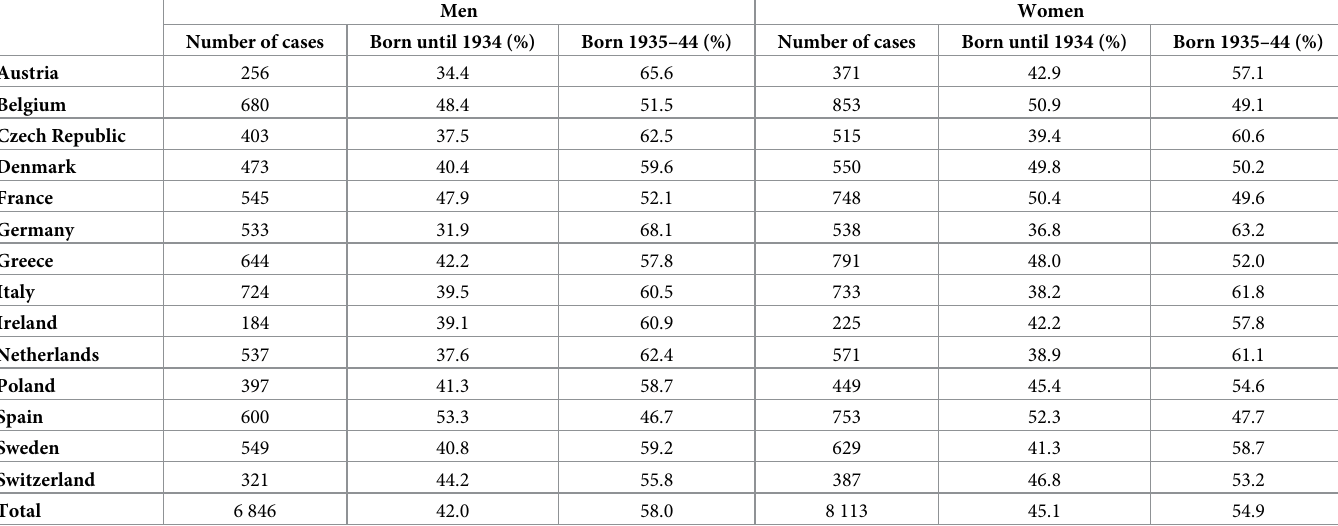
Table 2. Number, gender, and birth cohort of respondents, by country.